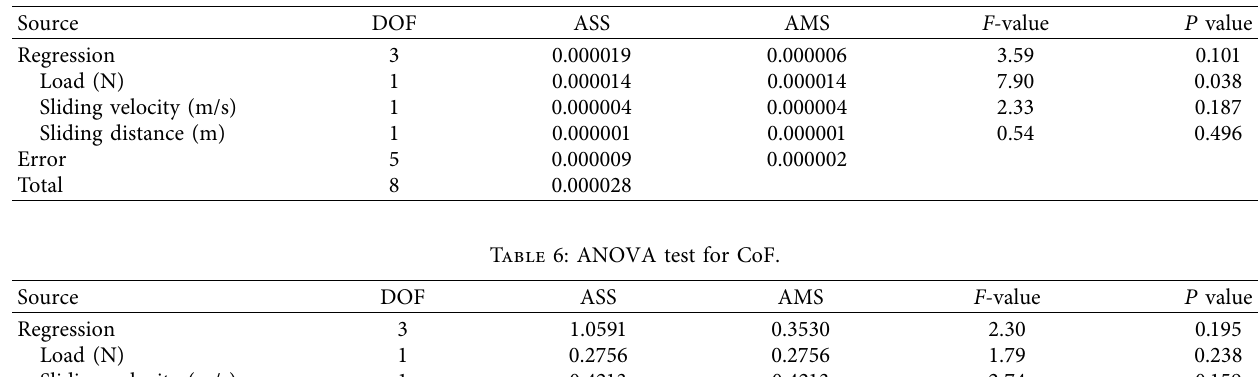
Table 5: ANOVA test for wear loss.